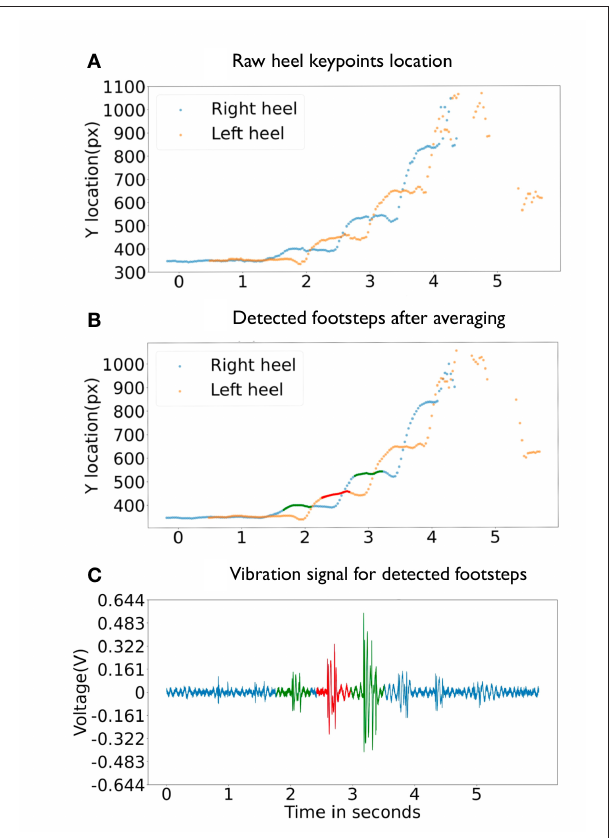
FIGURE 4 | Cross-modal footstep event signal association example. (A) shows heel keypoints location detected in video frames before smoothing. (B) shows heel keypoints location detected in video frames after smoothing. The red and greed dots mark detected footstep event. (C) shows the floor vibration signal in blue lines and extracted footstep event signal segments detection by the cross-modal context in red and green segments.